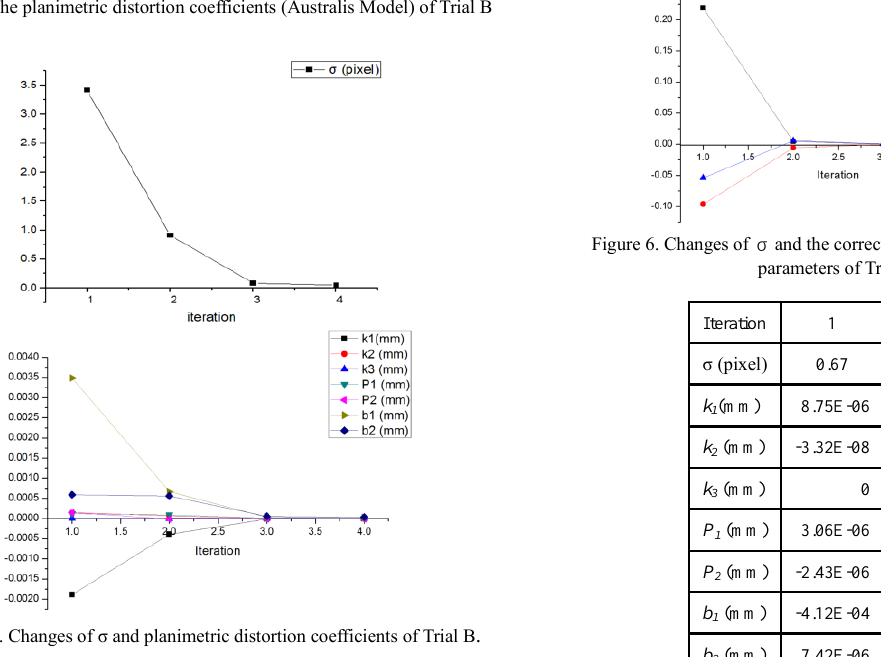
Table 6. The planimetric distortion coefficients (Australis Model) of Trial B